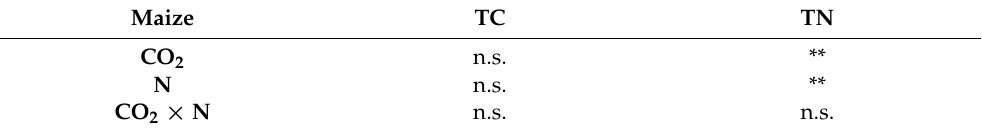
Table 7. Maize Two-factor ANOVA analyses for indices in the root exudate of wheat. Maize TC TN CO 2 n.s. N